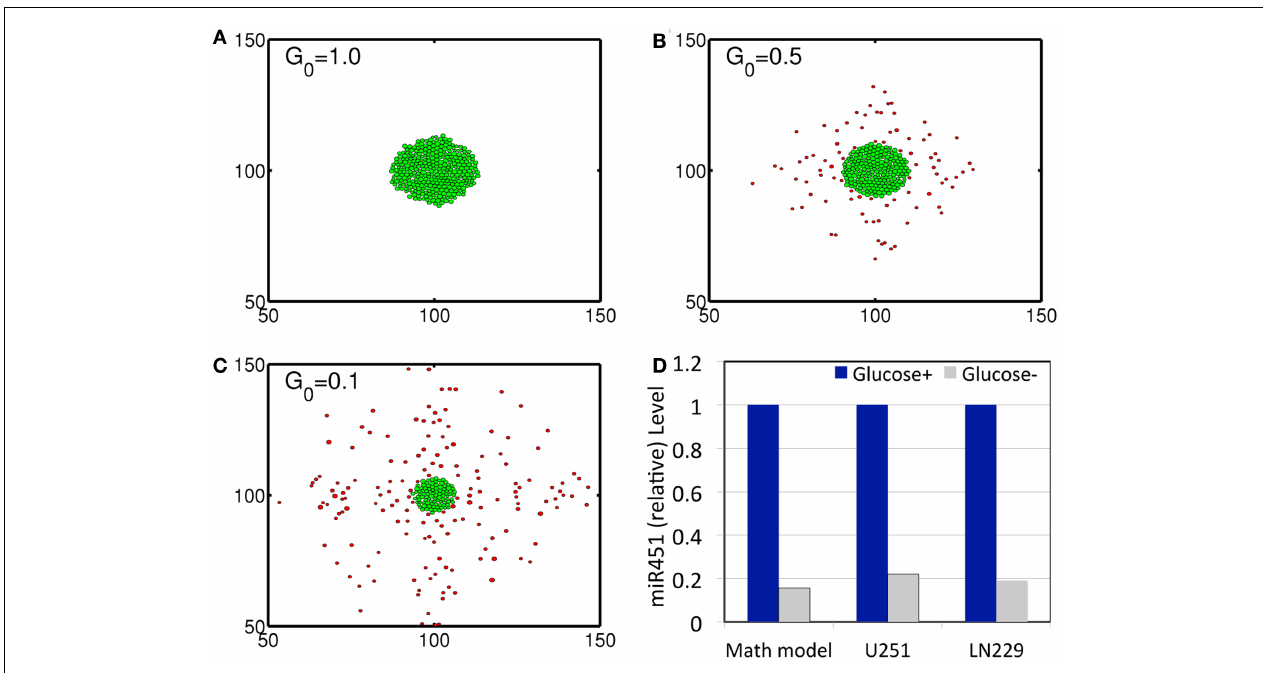
( Glucose − , gray) glucose levels, miR-451 expression levels are quantified. Simulation results are in good agreement with experimental results on U251 = 0. It was and LN229 cell line in Godlewski et al. (2010a). * λ b = 0, λ G in assumed that tumor cells respond to the glucose gradient for migration in vitro as in Godlewski et al.